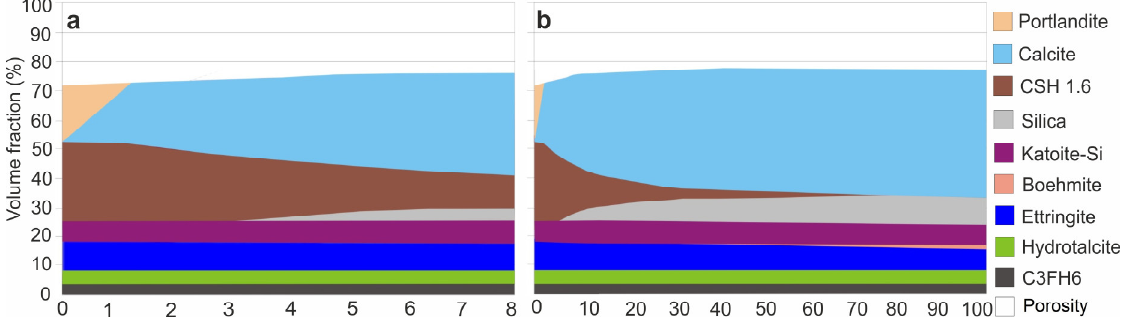
Figure 6. Mineralogical changes in Portland cement over 8 years of CO 2 injection ( a ) and over the 100 years after the completion of injection ( b ).